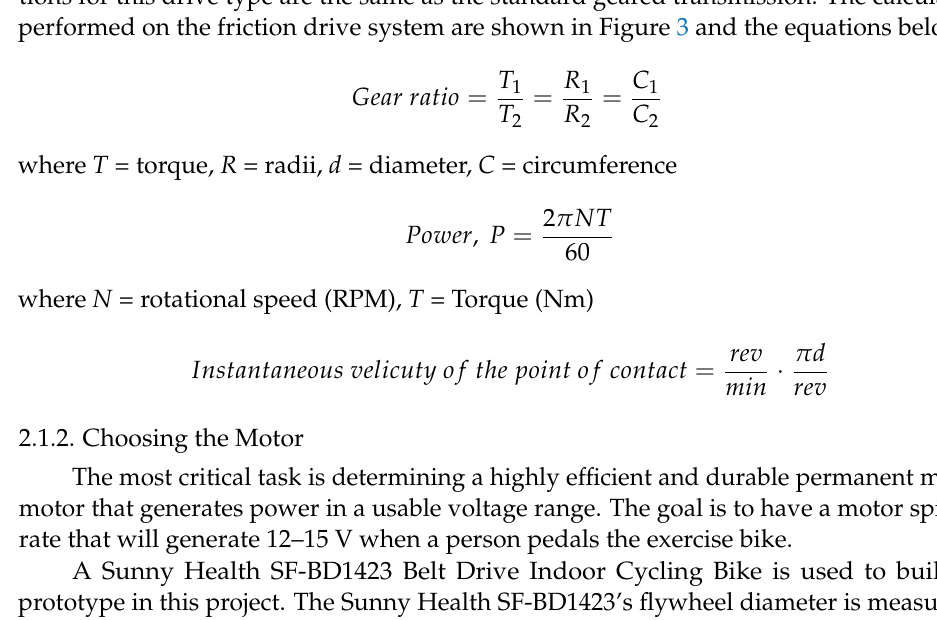
Figure 3. ( a ) Motor and flywheel free body diagram; ( b ) the free body diagram of the motor; and ( c ) the free body diagram of the flywheel.